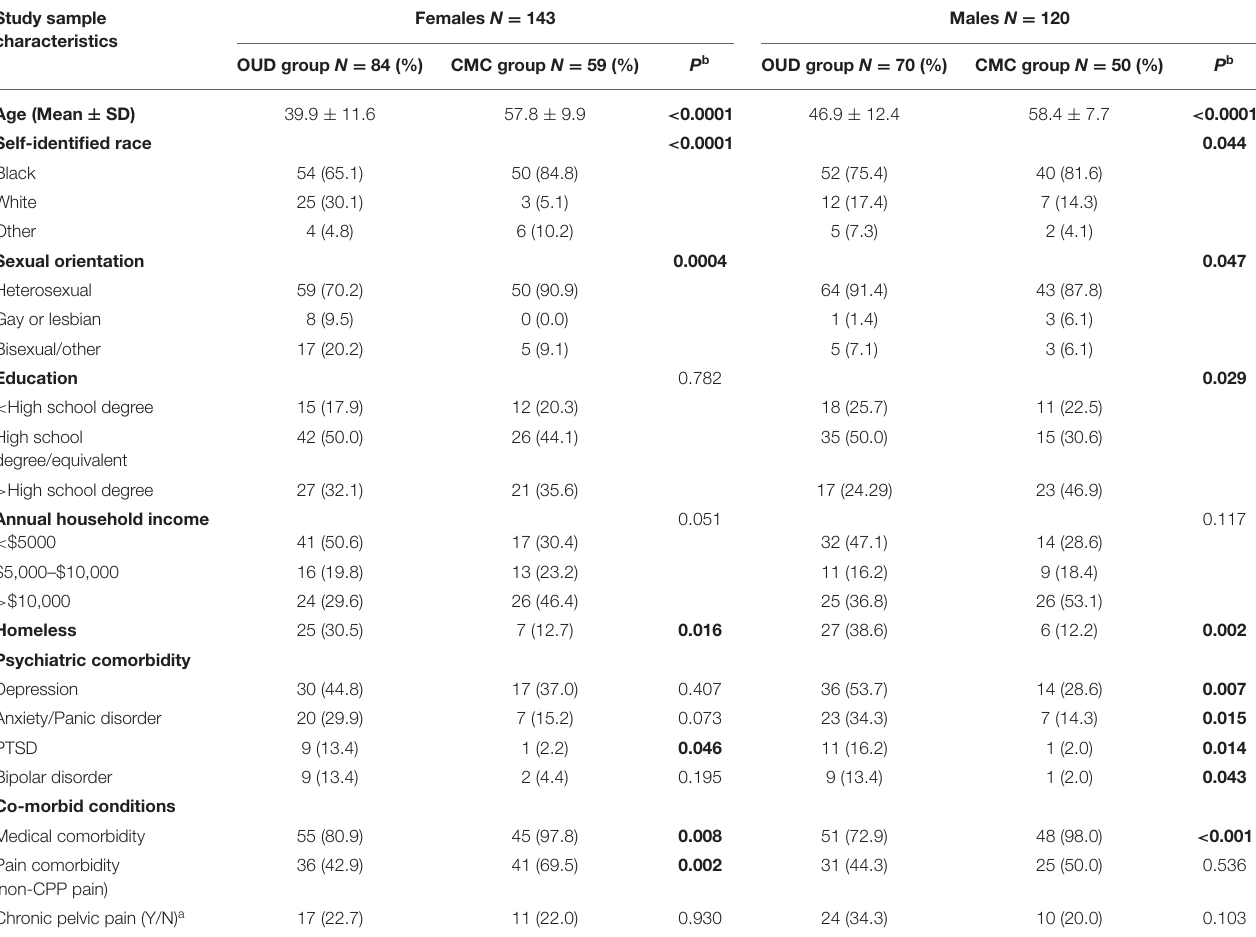
TABLE 1 | Demographic and psychosocial characteristics of study sample. Study sample